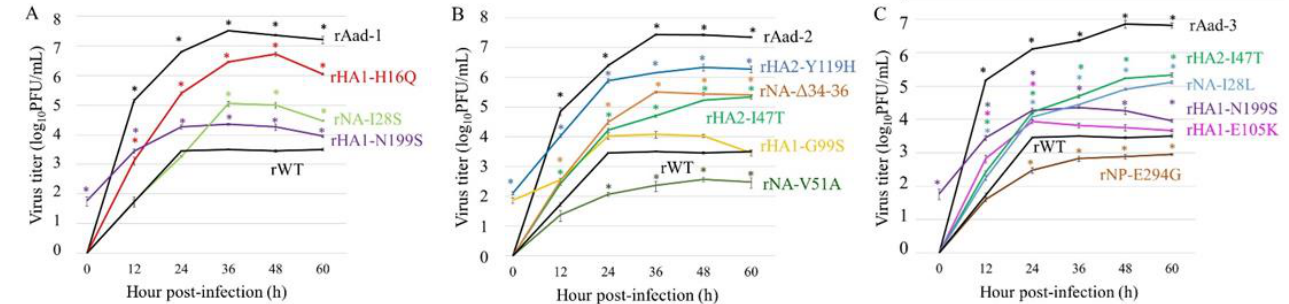
Figure 4. Growth kinetics of the mutant viruses in A549 cells. The cells were infected with recombinant wild-type virus (rWT), A549-adapted viruses, or mutant viruses possessing each mutation at a multiplicity of infection of 0.01 at 37 °C. ( A ) The growth of the mutant viruses found in Aad-1 (rHA1-H16Q, rHA1-N199S, or rNA-I28S), rAad-1, and rWT; ( B ) the growth of the mutant viruses found in Aad-2 (rHA1-G99S, rHA2-I47T, rHA2-Y119H, rNA- ∆ 3436, or rNA-V51A), rAad-2, and rWT; and ( C ) the growth of the mutant viruses found in Aad-3 (rHA1-E105K, rHA1-N199S, rHA2-I47T, rNP-E294G, or rNA-I28L), rAad-3, and rWT were included. Supernatants were harvested at the indicated time points. Virus titers were determined by plaque assays in MDCK cells. Data present the means ± SD of the results of three independent experiments. * p < 0.05, compared with that of rWT using Dunnett’s test.